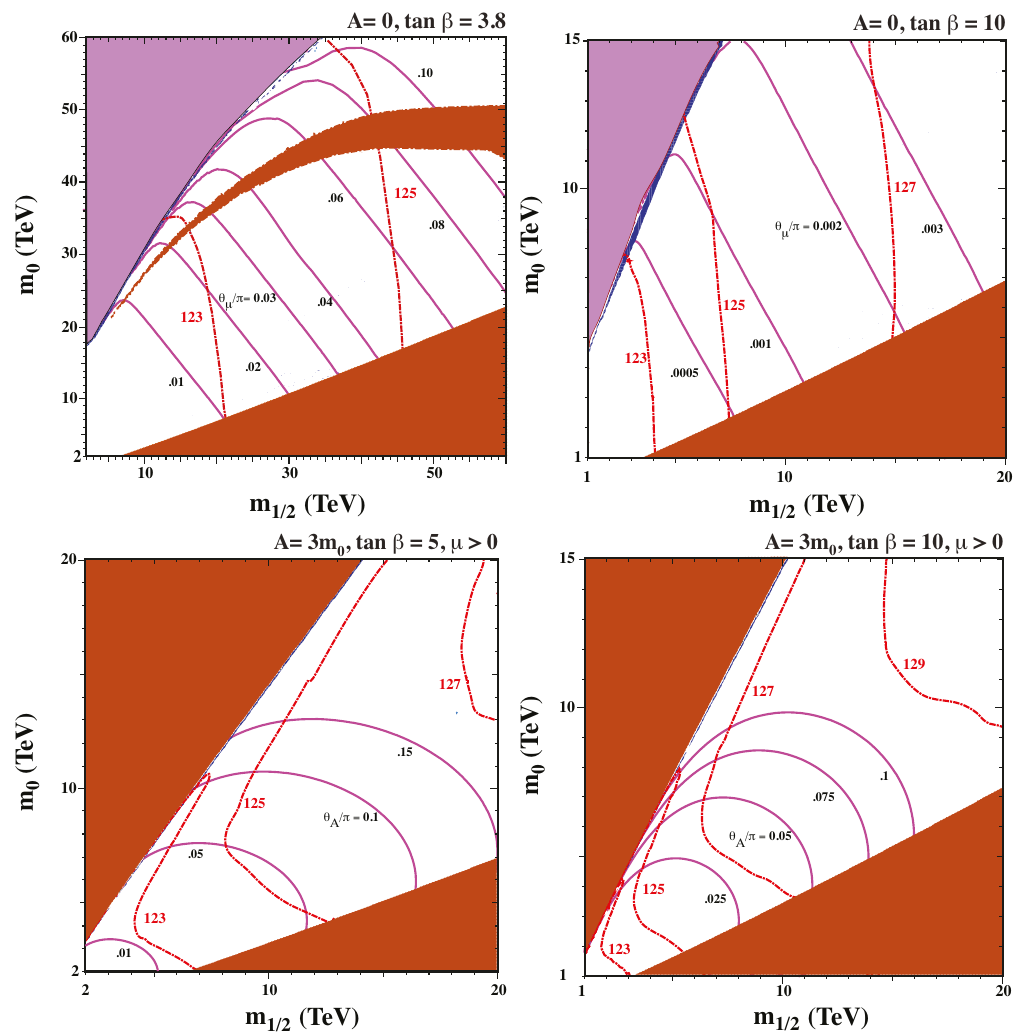
Figure 2 . Limits from the electron EDM for several values of θ µ (upper panels) and several values of θ A (lower panels) for the same parameter planes shown in figure 1. Regions of parameter space below and/or to the left of each the solid blue curves is excluded for that value of θ µ or θ A